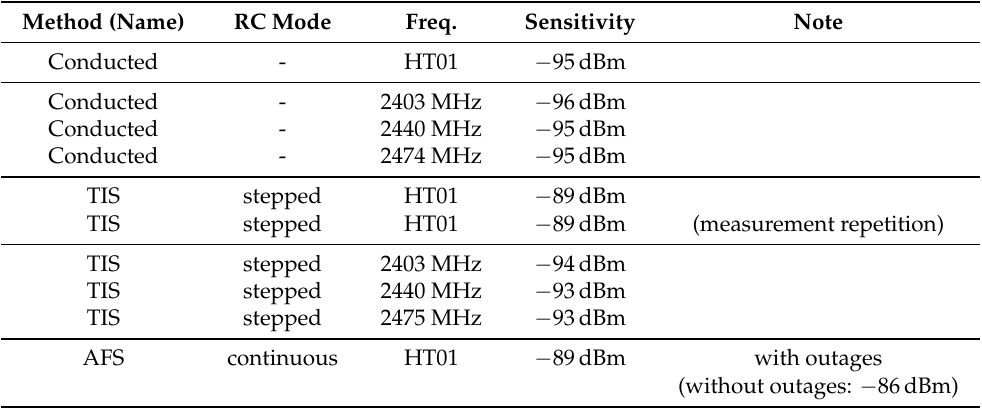
Table 6. Results of the TIS and AFS methods and conducted measurements (each rounded to integer